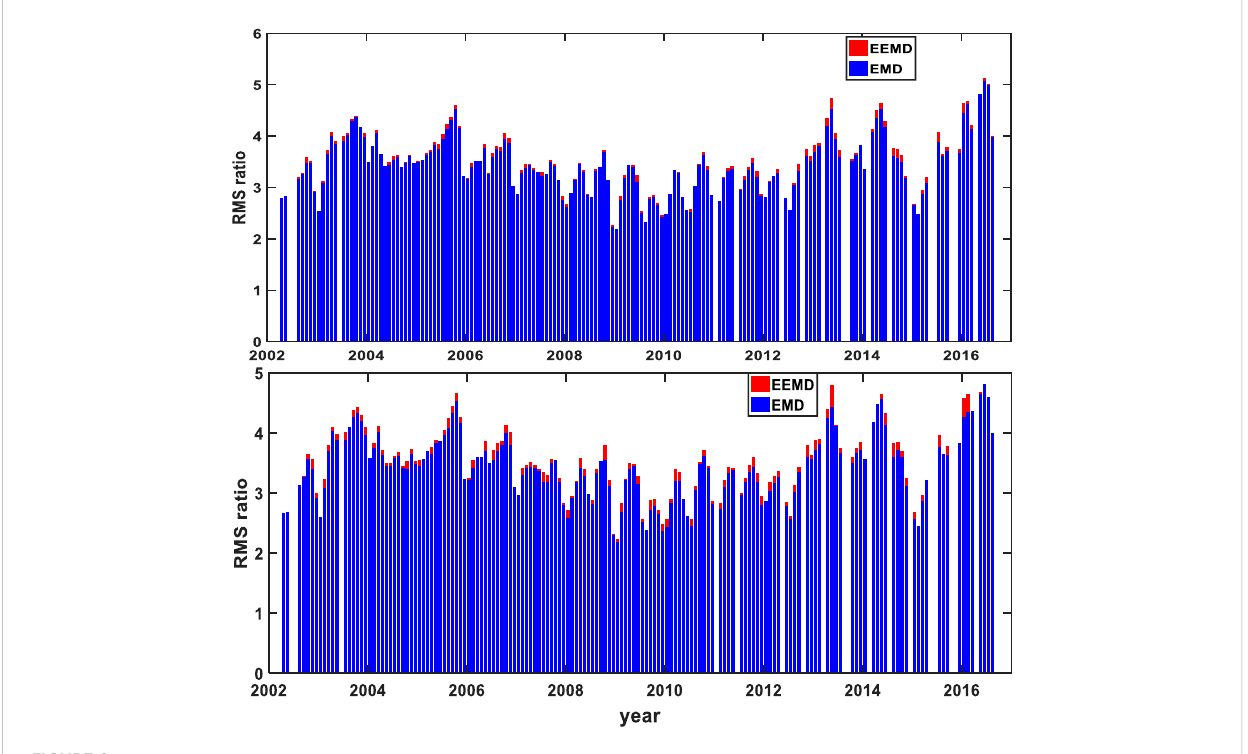
FIGURE 9 The RMS_ratios of all available months from April 2002 to August 2016 by EEMD and EMD (Up: Improving the endpoint effect) and (Bottom: No improving the endpoint effect).